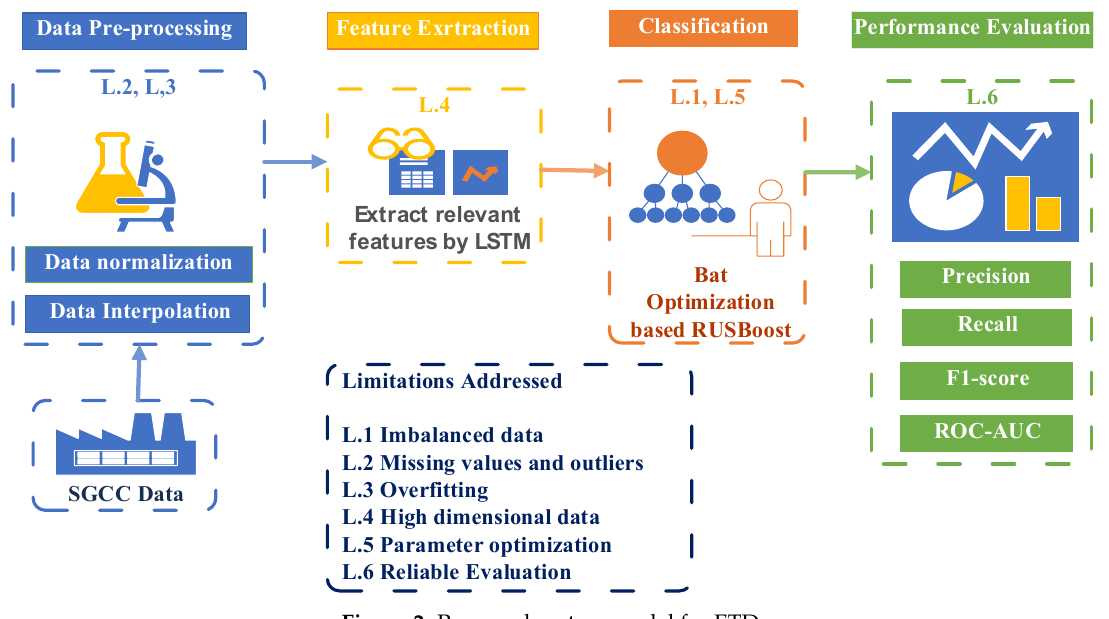
Figure 2. Proposed system model for